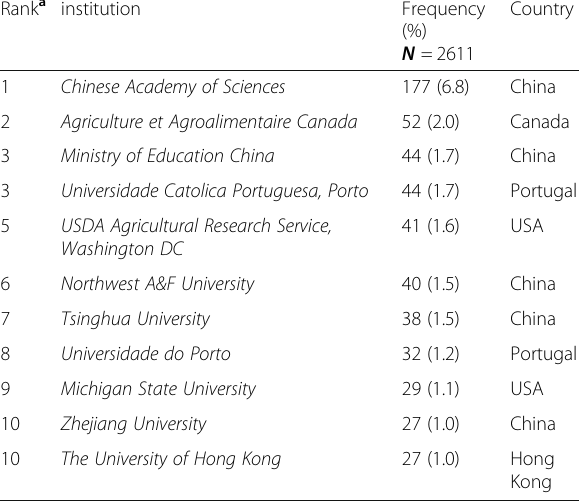
Table 3 List of top ten active institutions in AMR in the environment (2000 –